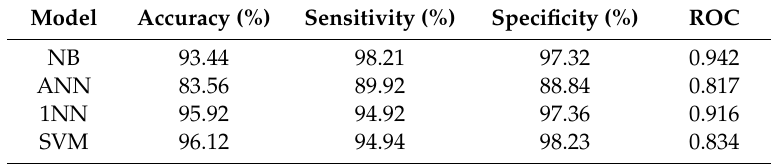
Table 8. Model performance evaluation after feature selection (with selective